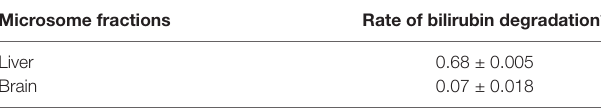
FIGURE 3 | Localization of CYP1A2 in the brain regions at different ages. (A) Localization of CYP1A2 in the VCN at P7. (B) Localization of CYP1A2 in the MVE at P7. (C) Localization of CYP1A2 in the PN at P7. (D) Localization of CYP1A2 in the CLL at P7. (E) Localization of CYP1A2 in the COR at P7. (F) Localization of CYP1A2 in the VCN at P14. (G) Localization of CYP1A2 in the MVE at P14. (H) Localization of CYP1A2 in the PN at P14. (I) Localization of CYP1A2 in the CLL at P14. (J) Localization of CYP1A2 in the COR at P14. (K) Localization of CYP1A2 in the VCN at P30. (L) Localization of CYP1A2 in the MVE at P30. (M) Localization of CYP1A2 in the PN at P30. (N) Localization of CYP1A2 in the CLL at P30. (O) Localization of CYP1A2 in the COR at P30. P, postnatal day. PN, pontine nucleus; VCN, ventral cochlear nucleus; MVE, medial vestibular nucleus; CLL, cerebellum; COR, cortex. TABLE 2 | Bilirubin degradation rate of microsomes. Microsome